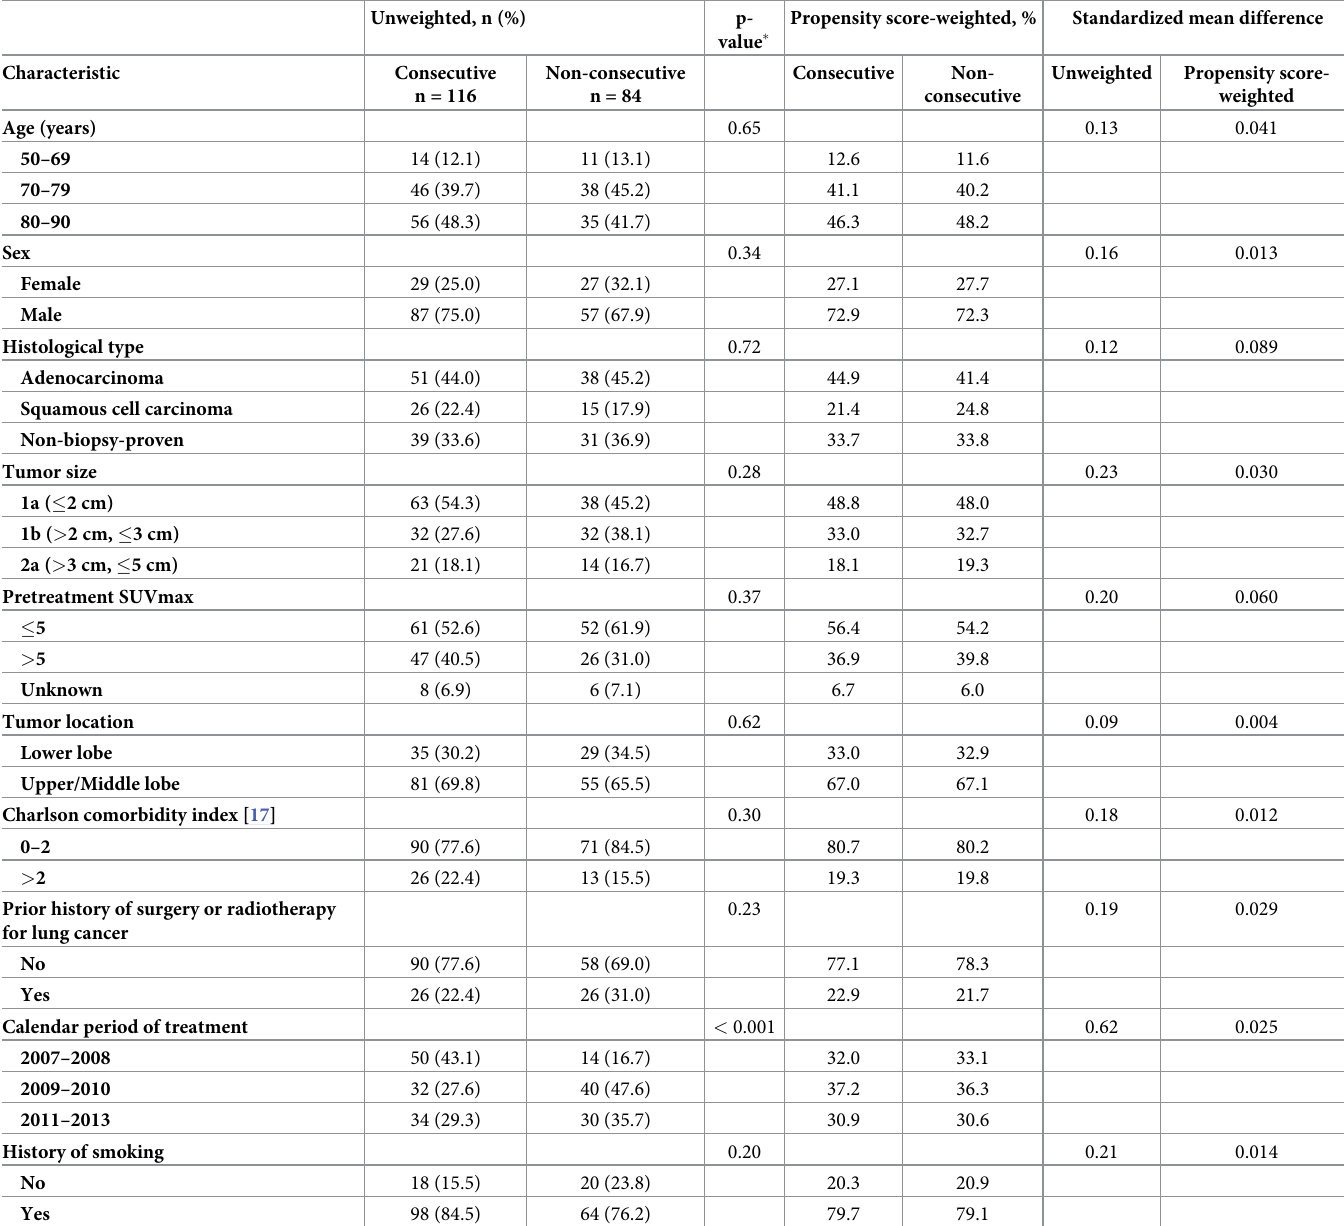
Table 1. Patient characteristics in the two treatment groups and standardized mean differences before and after propensity score weighting. Propensity score-weighted, Unweighted, n (%) p- value �